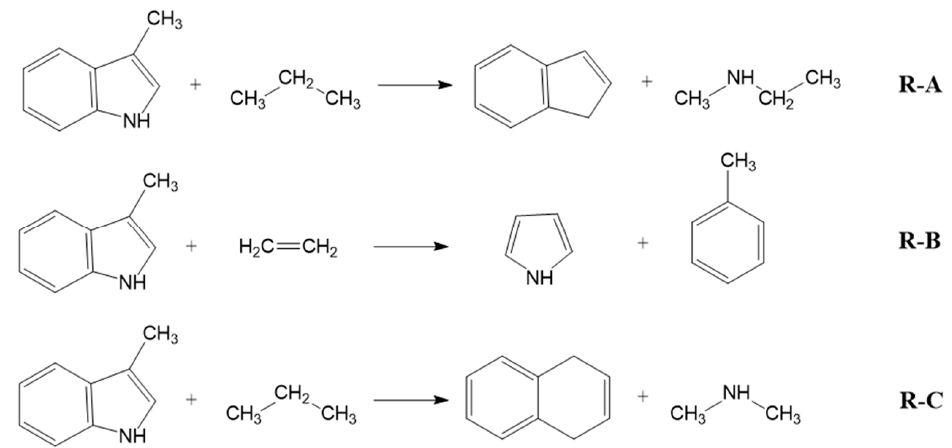
Figure 2. The homodesmotic reactions used to convert the H 298 -values to the theoretical standard molar enthalpies of formation ∆ f H o m (g, 298.15 K). Table 2. Results of the quantum chemical calculations of ∆ f H o m (g, 298.15 K) for 3-methyl-indole